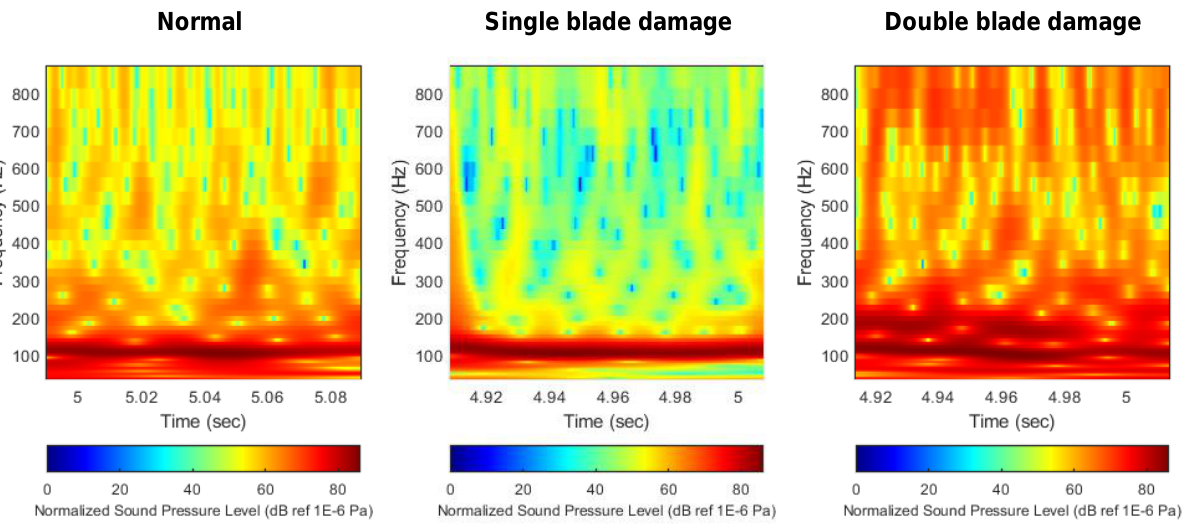
Figure 12. Comparison of flow noise scalogram with normalized decibel scale. ( left ) Normal, ( middle ) single-blade damage, ( right ) double-blade